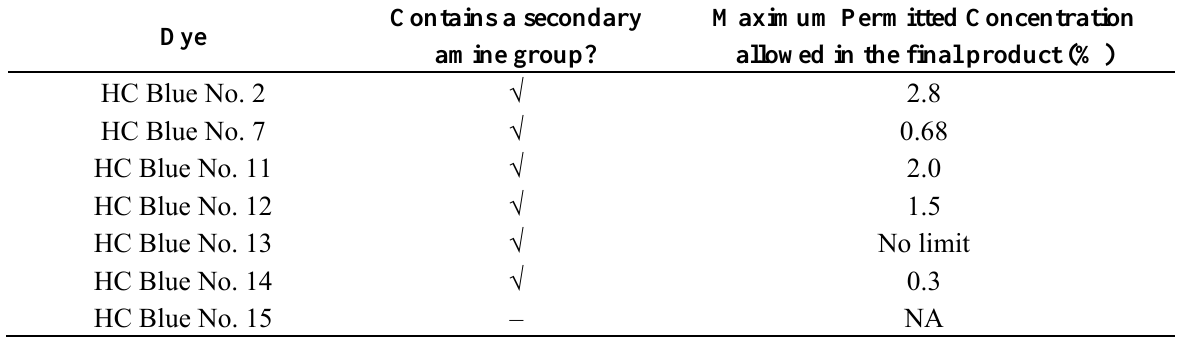
Table 1. Hair Color (HC) Dyes currently listed in the current EU Cosmetics Directive, their status as secondary amines and Maximum Permitted Concentration in final